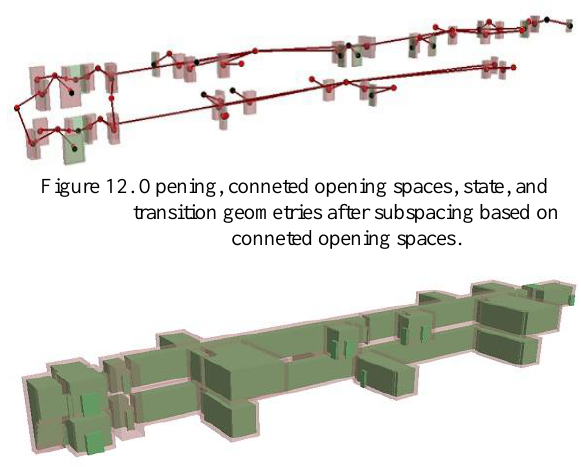
Figure 11. Building model (state, space, and transition geometries) after subspacing based on conneted opening spaces.